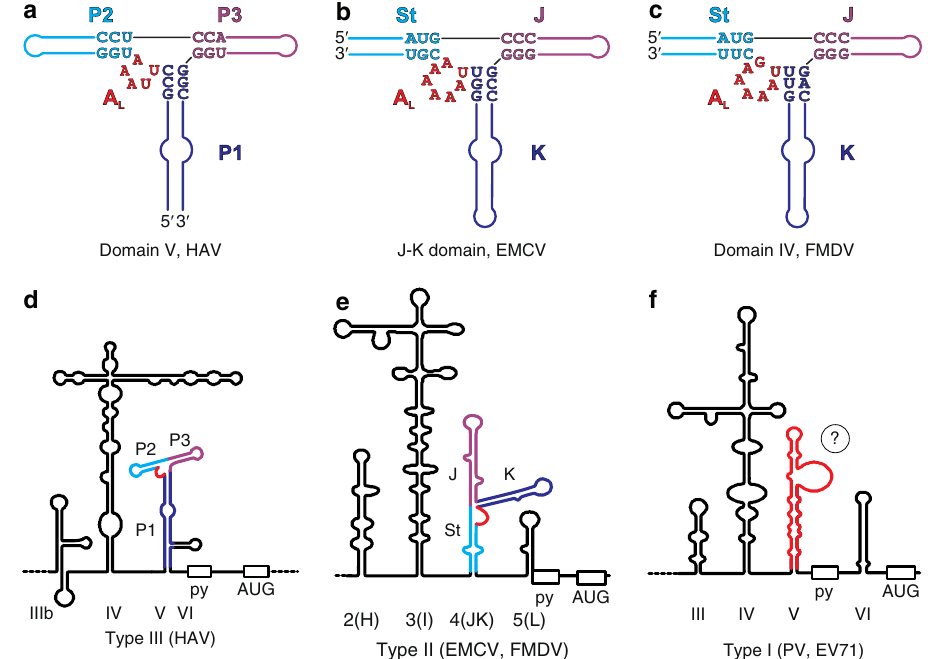
Fig. 6 Structural homology between the corresponding RNA domains from different types of picornaviral IRESs. a Secondary structure of HAV IRES (type III IRES) dV based on the crystal structure obtained in this work. b Secondary structure of EMCV IRES (type II IRES) J – K domain based on the